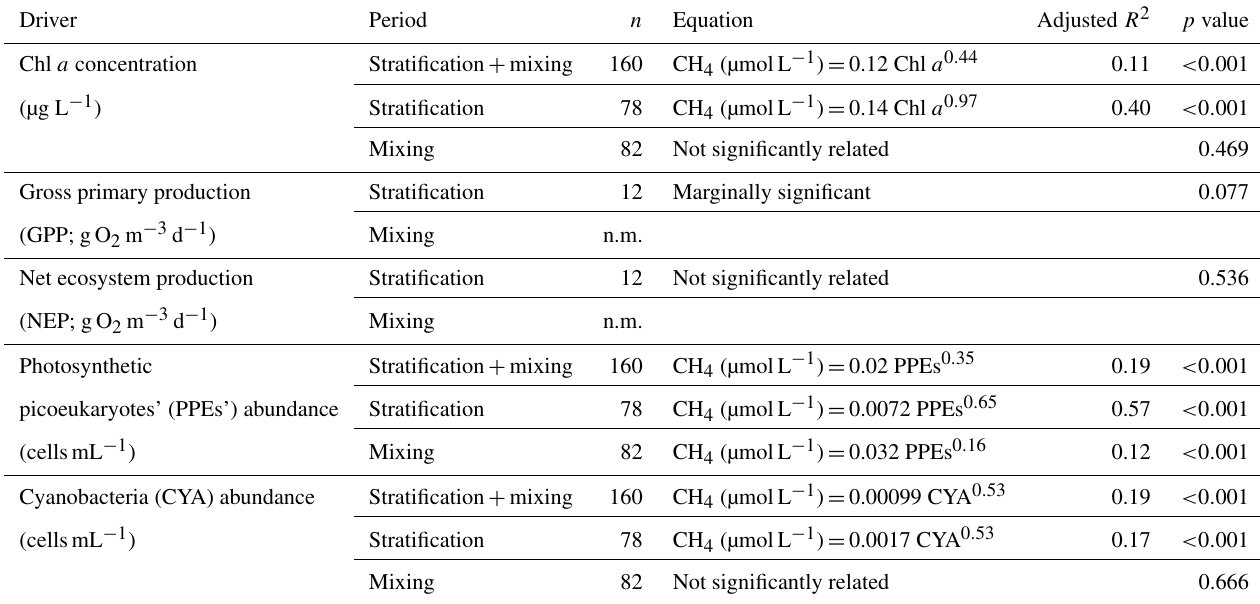
Table 3. Equations for the relationships between the phytoplanktonic variables and the dissolved CH 4 concentration in the oxic waters. n.m. means not